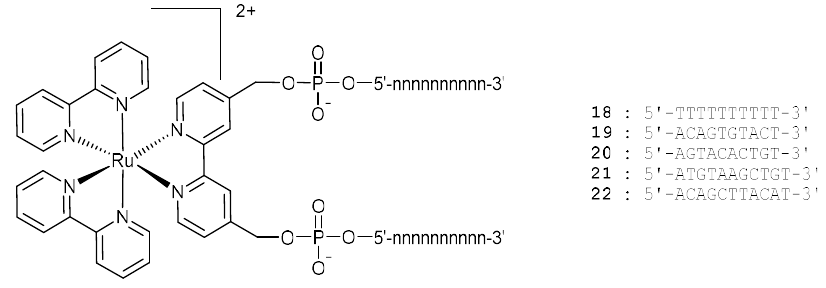
Figure 8. Structures of the Ru complex linked branched oligonucleotides 18 – 22 .